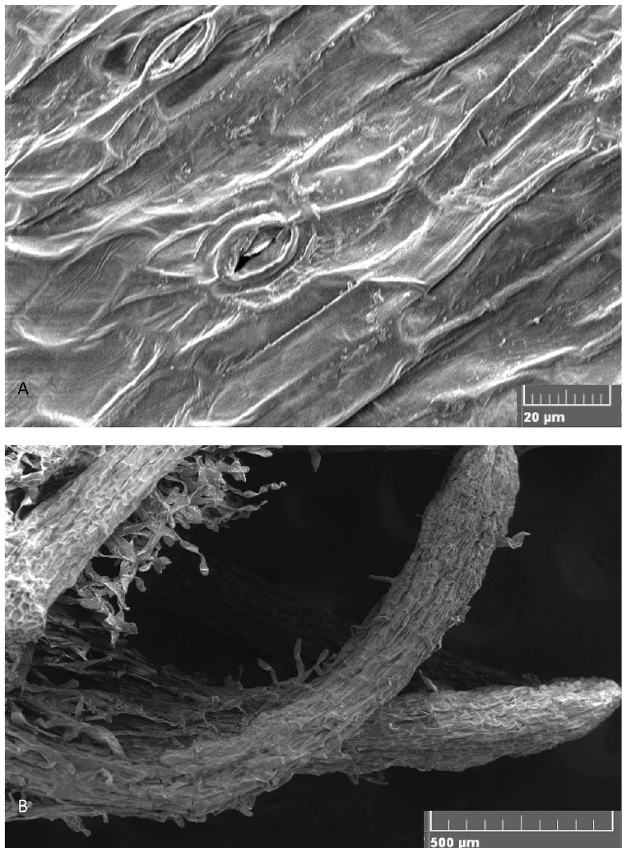
Figure 8. Scanning electron microscopic images. ( A ) Paracytic oblique type of stomata in TIB grown plantlets. ( B ) Lateral roots of TIB grown